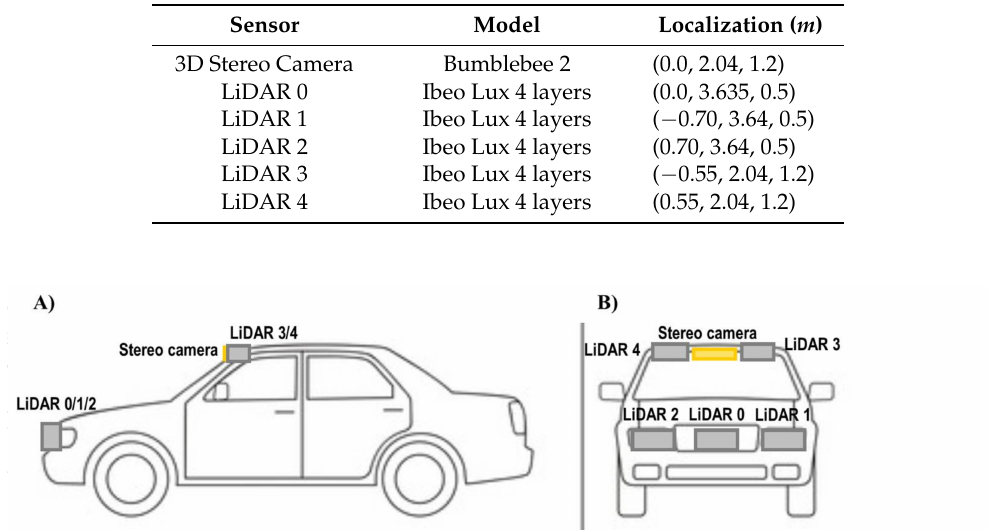
Table 4. Localization of each sensor that comprises the IoT sensory system.